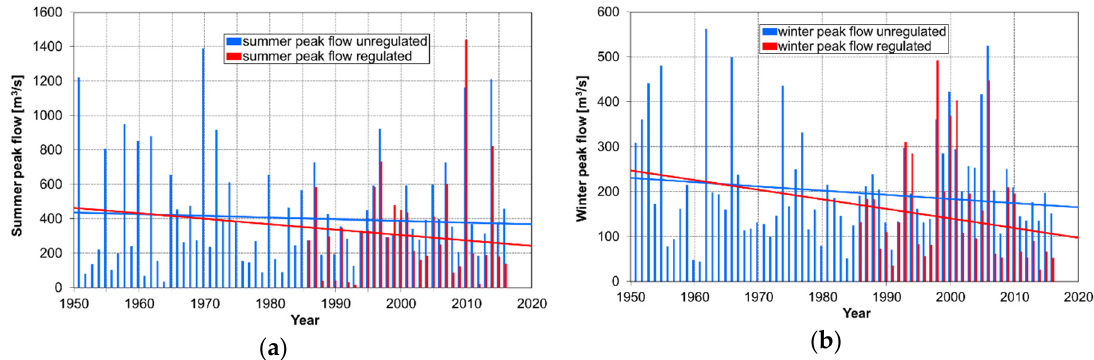
Figure 2. Regulated (red color) and unregulated (blue color) peak flows at the Proszówki gauging station along with the trends in their average values for the ( a ) summer season; ( b ) winter season.